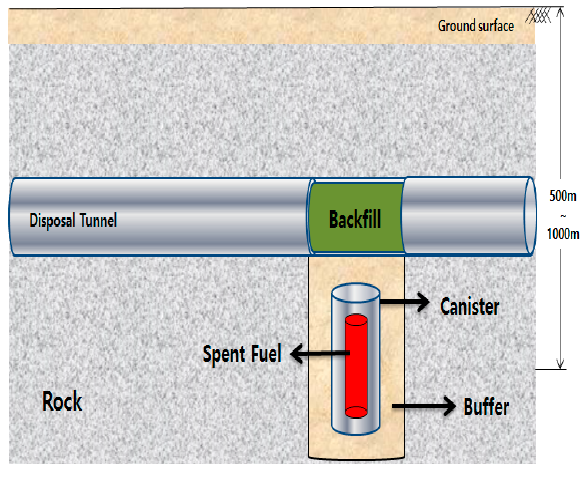
Figure 1. Engineered barrier system.